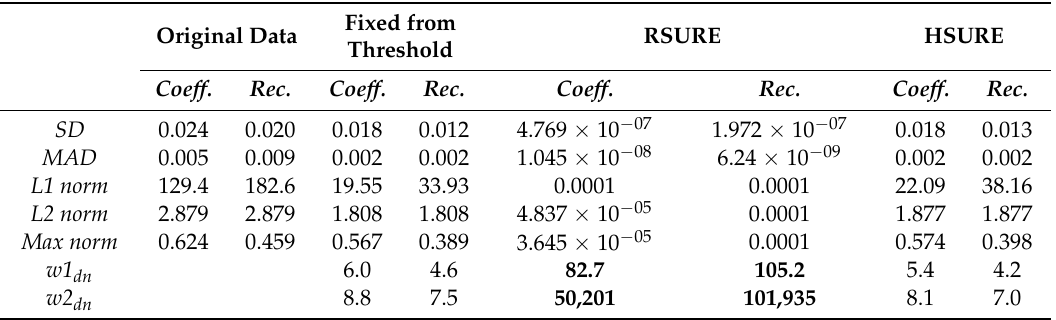
Table 3. Statistics for the coefficients and reconstruction of the original and denoised signals for a power line (data set